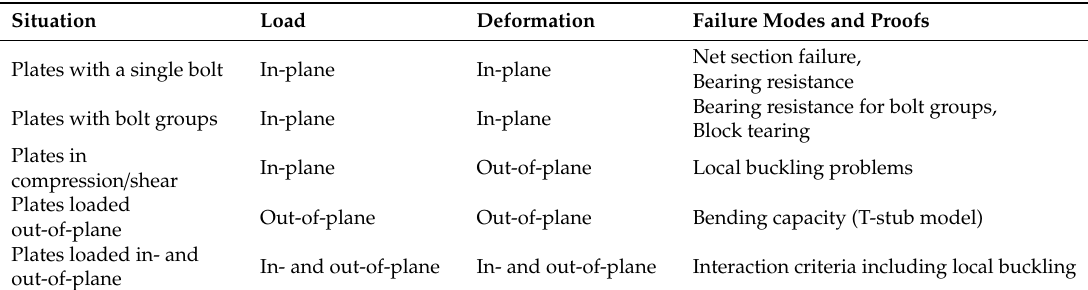
Figure 1. Typical steel connections. The connection plates are shaded in grey: ( a ) Plate mainly in bending (plate is loaded in- and out-of-plane); ( b – d ) plates are loaded in-plane. Table 1. Categorization of connection plates, depending on the loading situation and the deformation